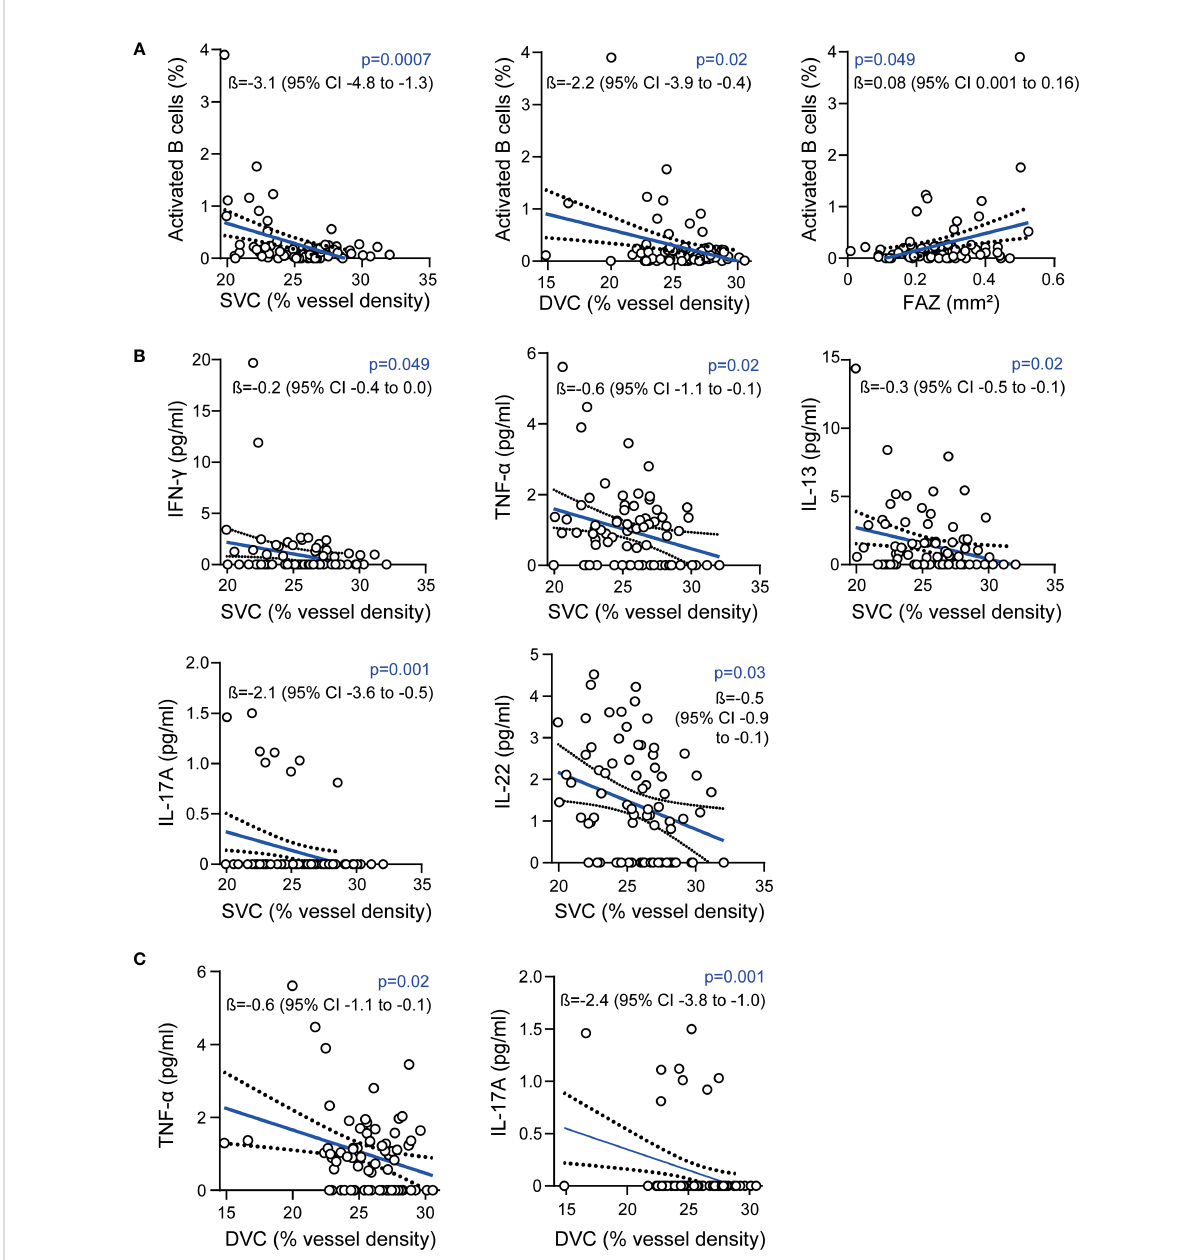
FIGURE 1 Association of the retinal vasculature and intrathecal immunity (A) Association of vessel densities of the super fi cial vascular complex (SVC), deep vascular complex (DVC), the foveal avascular zone (FAZ) and frequencies of intrathecal activated B cells; (B) Association of intrathecal cytokine levels and vessel densities of the SVC; (C) Association of intrathecal cytokine levels and vessel densities of the DVC; (A – C) : 87 patients, multiple linear regression models corrected for age and sex; ß estimates and 95% con fi dence (CI) intervals; interferon- g (IFN- g ), tumor necrosis factor a (TNF- a ), interleukin